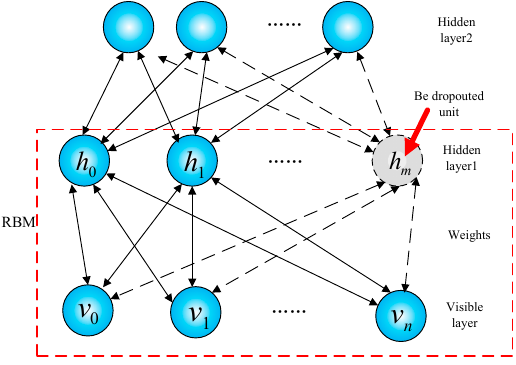
Figure 2. Dropout in unsupervised training.